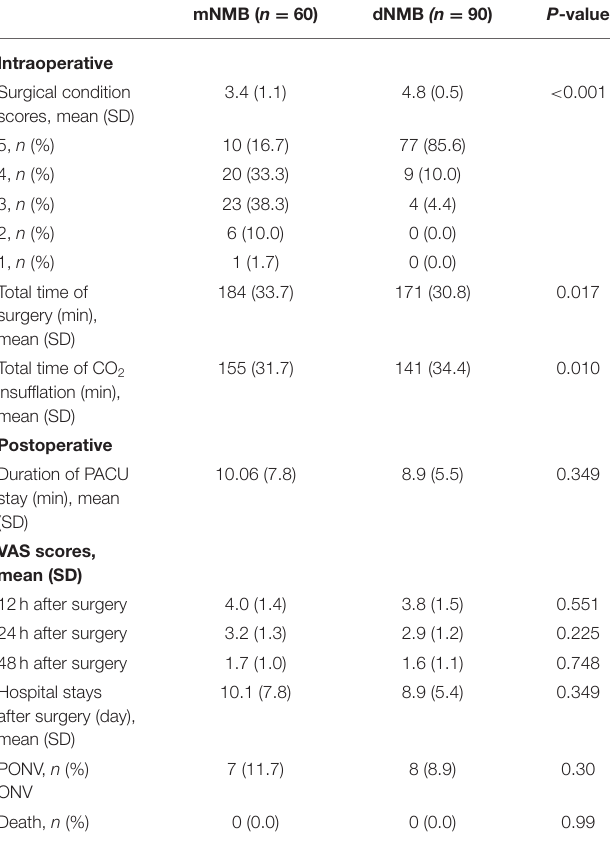
TABLE 3 | Intra- and postoperative